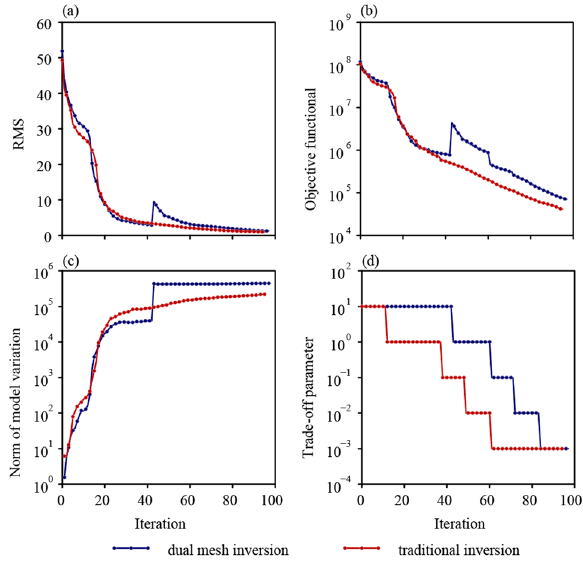
Figure 9. Inversion parameters versus iterations for the dual-mesh and conventional methods. ( a ) RMS; ( b ) Objective functional; ( c ) Model; ( d ) Trade-o ff parameter.